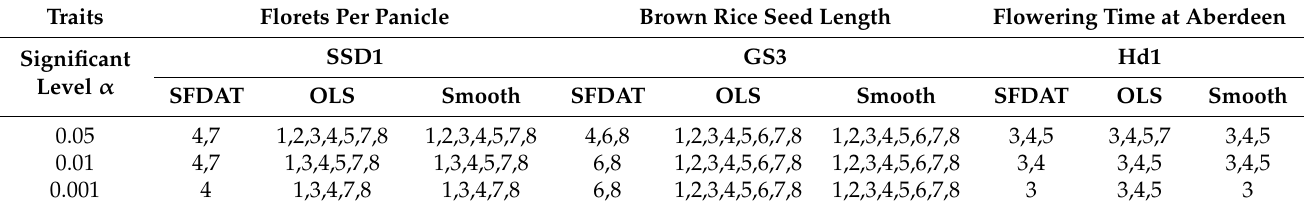
Figure 4. The position of SNPs that in O. sativa data analysis on chromosomes. Chromosome ID is the numbering of each chromosome. D10 and D14 are the causal SNPs of culm habit; SSD1 , GS3 and Hd1 are the candidate SNPs of florets per panicle, brown rice seed length and flowering time at Aberdeen, respectively. Table 7. The gene regions of candidate SNP identified by SFDAT, OLS and Smooth at different significant levels.